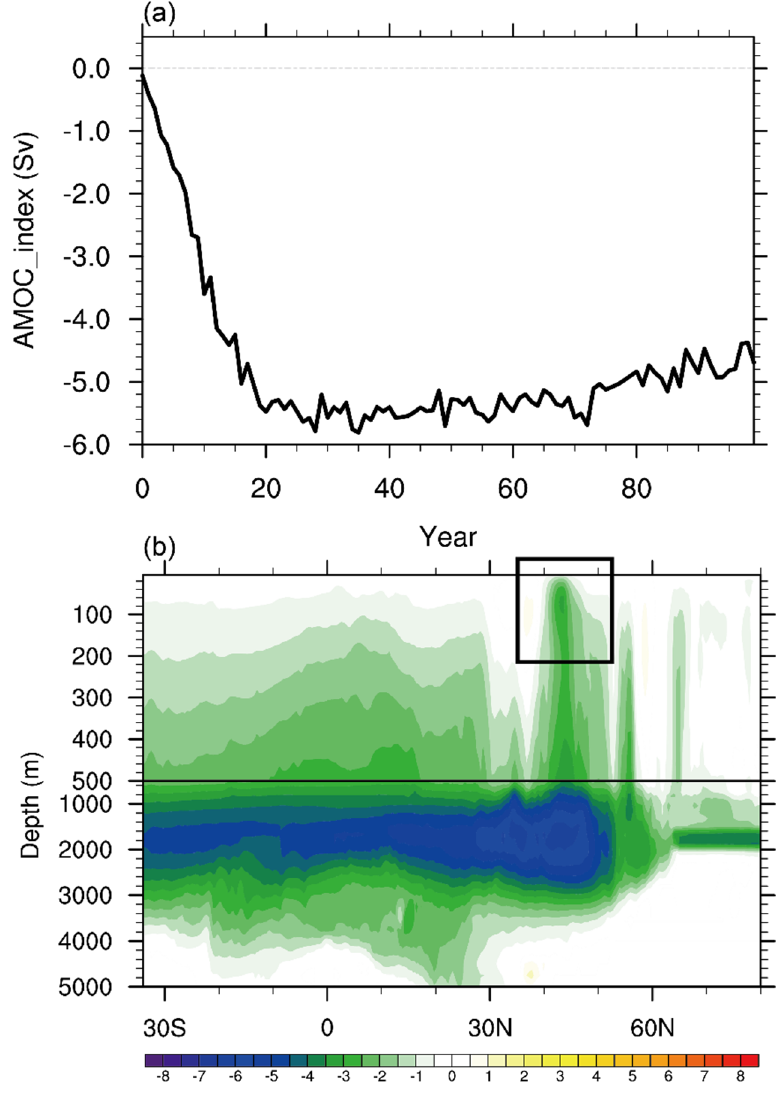
Figure 5. ( a ) The temporal evolution of the AMOC index (unit: Sv, 1 Sv = 10 6 m 3 /s) in FOM. The AMOC index is defined as the maximum value of the streamfunction in the region of 20–70° N, 300–2000 m in the Atlantic. ( b ) The quasi-equilibrium AMOC responses to Arctic sea ice loss in FOM. The black box shows the positon of the Gulf Stream and GE.